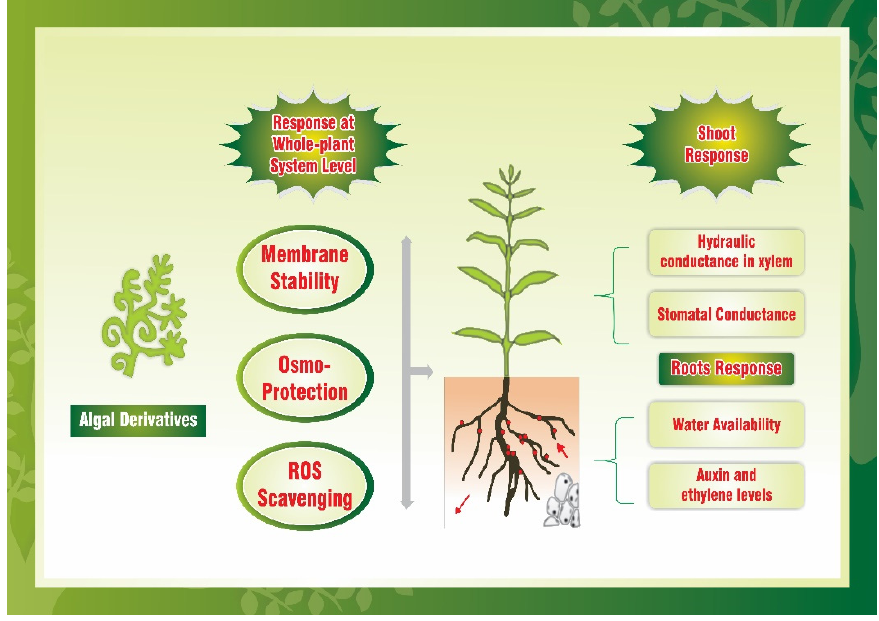
Figure 1. The key metabolic processes at the whole-plant level and physiological level are targeted by algal-based biostimulants [101].